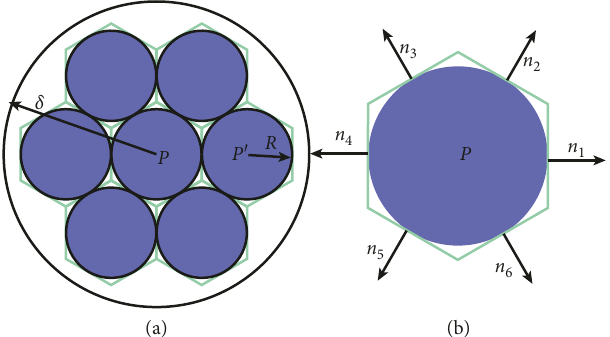
Figure 3: Triangular lattice accounting for nearest neighbors. (a) Cell representation. (b) Normal vector